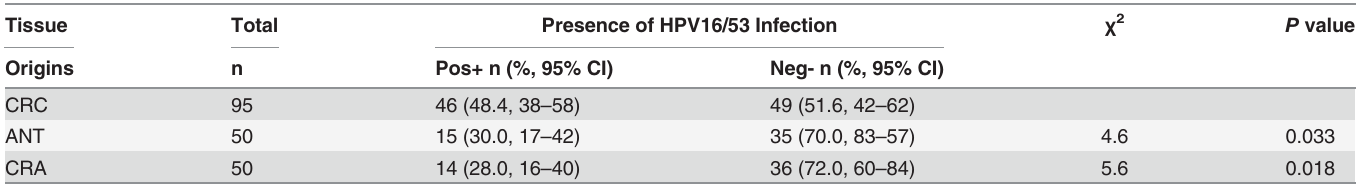
Table 2. Colorectal cancer (CRC) tissues have a higher rate of high-risk HPV infection, than both adjacent normal tissues (ANT) and colorectal adenoma tissues (CRA).